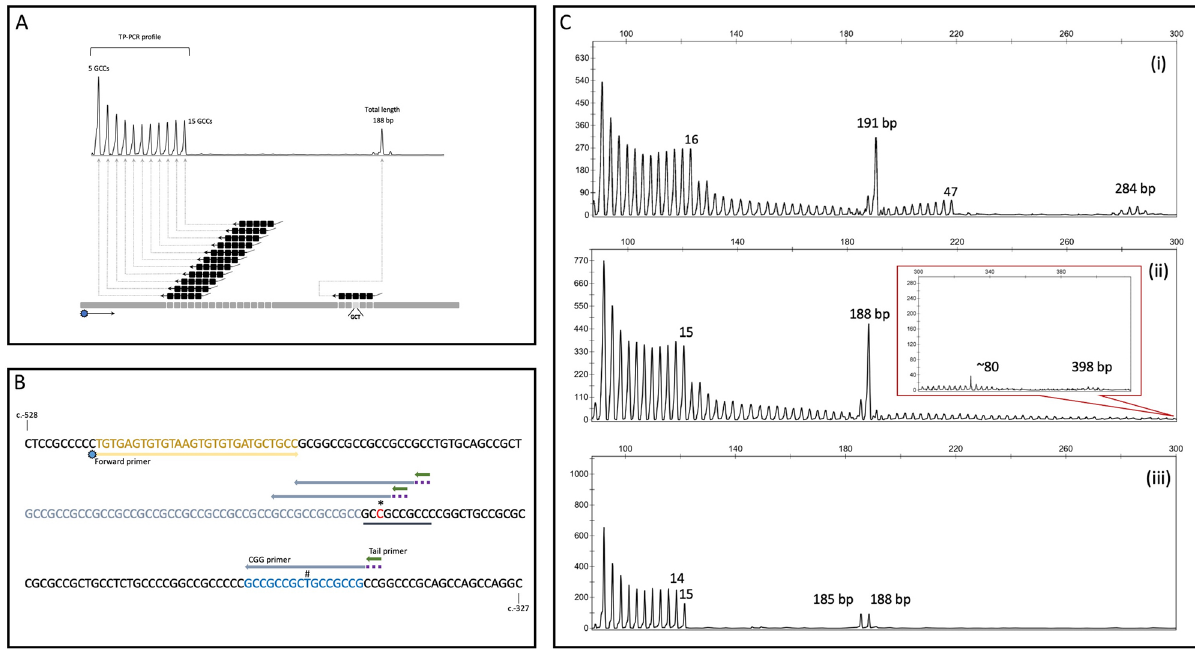
Figure 1. ( A ) Diagram of the TP-PCR principle. Grey squares represent tandem GCC repeats at the AFF2 gene 5 ′ UTR. Black squares represent annealing of "CGG primer” within the GCC tract and in a second priming site overriding the rs1333167094 “T” SNP (when GCT is located exactly in the middle of the (CGG)5C primer sequence). Above is an electropherogram illustration after capillary electrophoresis on automatic sequencer, reflecting the total repeat length (higher rightmost peak), that corresponds to the distance between the forward primer and the sole GCC priming site 52 bp downstream of the end of the repeat. The image is not at scale; ( B ) Partial AFF2 sequence (GRCh37/hg19, NM_002025.3) harbouring the primer binding sites. Annealing sites within the GCC repeats (light blue), generating stutters, and at (GCC)2GCT(GCC)2G sequence located 52 nucleotides downstream (dark blue). “Forward primer” and corresponding binding site (yellow); “CGG primer” (blue arrow and dashed purple line) (CGG)5C; Tail primer (green arrow) and SNPs c.-413T > C rs868949662 (*) (highest population MAF: 0.02) and c.-355T > C rs1333167094 (#) (highest population MAF: < 0.01) are also indicated. In case of rs868949662 “C”, the nucleotide following the 3rd GCC triplet is a “C” hampering its Female heterozygous sample with normal and expanded alleles; superimposed close-up electropherogram shows the continuous stuttering after the prominent peak with 188 bp, an indication of the presence of